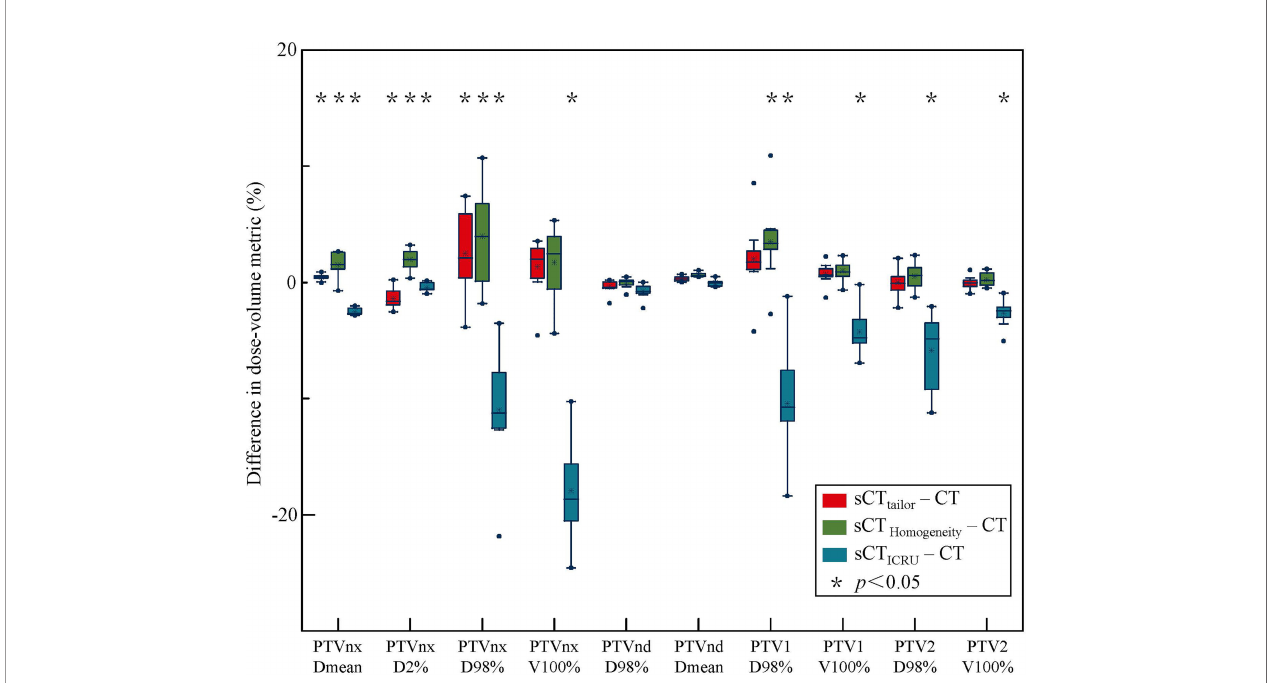
FIGURE 2 | Box-plot analysis related to the dose differences of sCT tailor , sCT ICRU and sCT Homogeneity respect to the original CT for different DVH parameters related to PTV coverage. A * indicates a signi fi cance of p < 0.05.